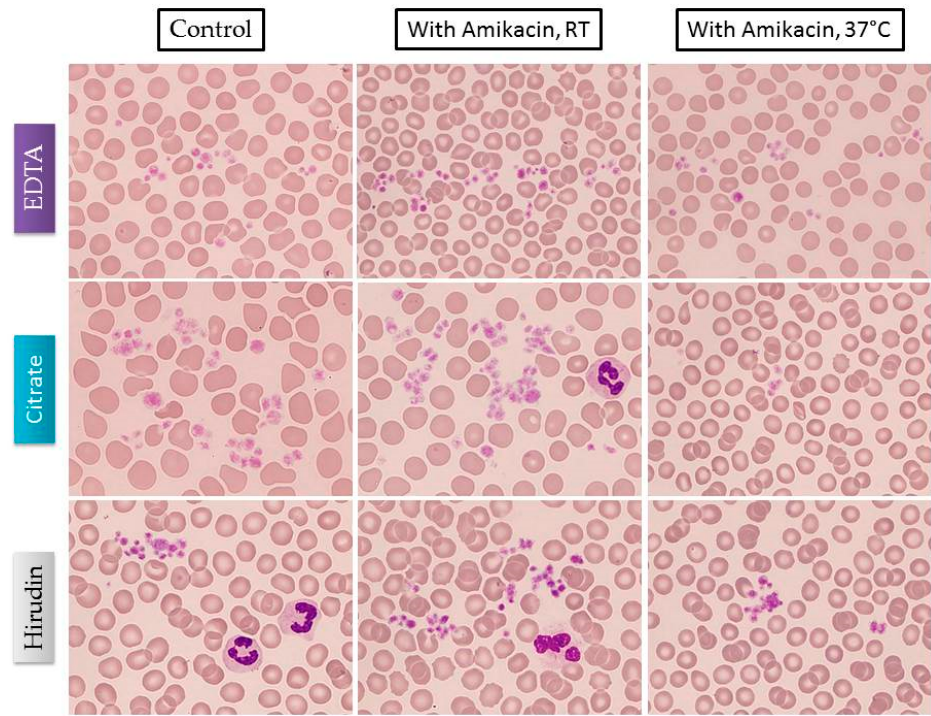
Figure 2. Platelet clumps observed on blood smears from samples obtained at baseline according to different anticoagulants tubes and conditions. Clumps were observed until the last observation at 240 min. Although not illustrated, amikacin-free specimens also displayed several clumps. Abbreviations: EDTA, ethylenediaminetetraacetic acid.; RT, room temperature.